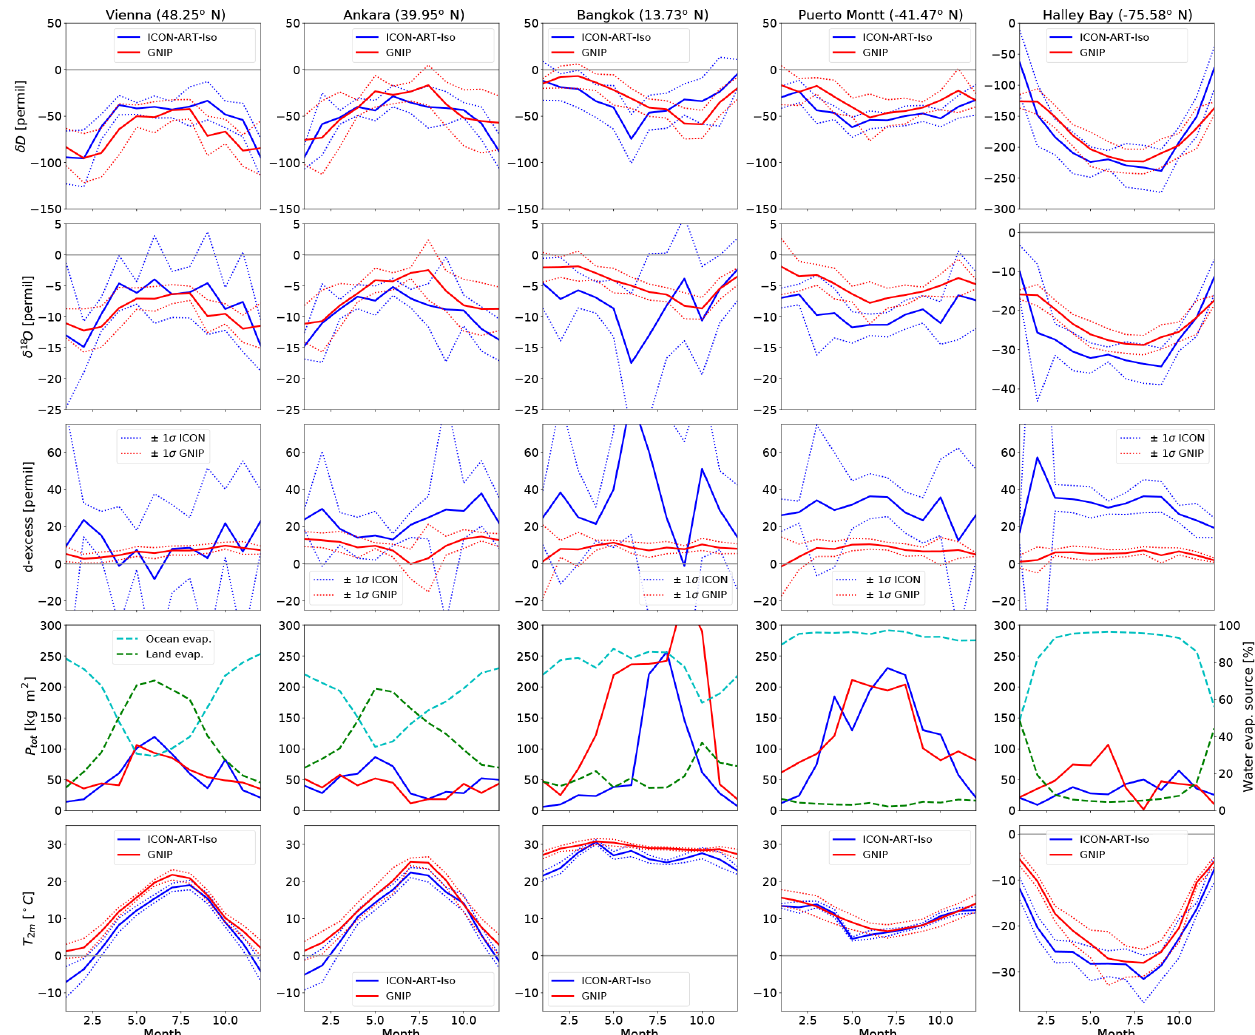
Figure 2. Monthly mean data for five GNIP stations (left to right: Vienna, Ankara, Bangkok, Puerto Montt and Halley station). Variables listed from top to bottom: δ D, δ 18 O, d-excess ( δ D − 8 δ 18 O), total precipitation P tot and 2m temperature ( T 2m ). Plots showing P tot also include the percentage of land and ocean evaporation in precipitation. The 1 σ standard deviation interval is indicated by dashed lines (except P for